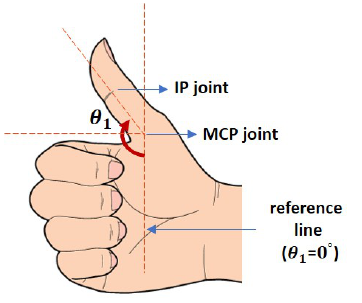
Figure 7. Illustration on the goniometry of the thumb and its’ reference line. The figure shows θ 1 = 135 ◦ .